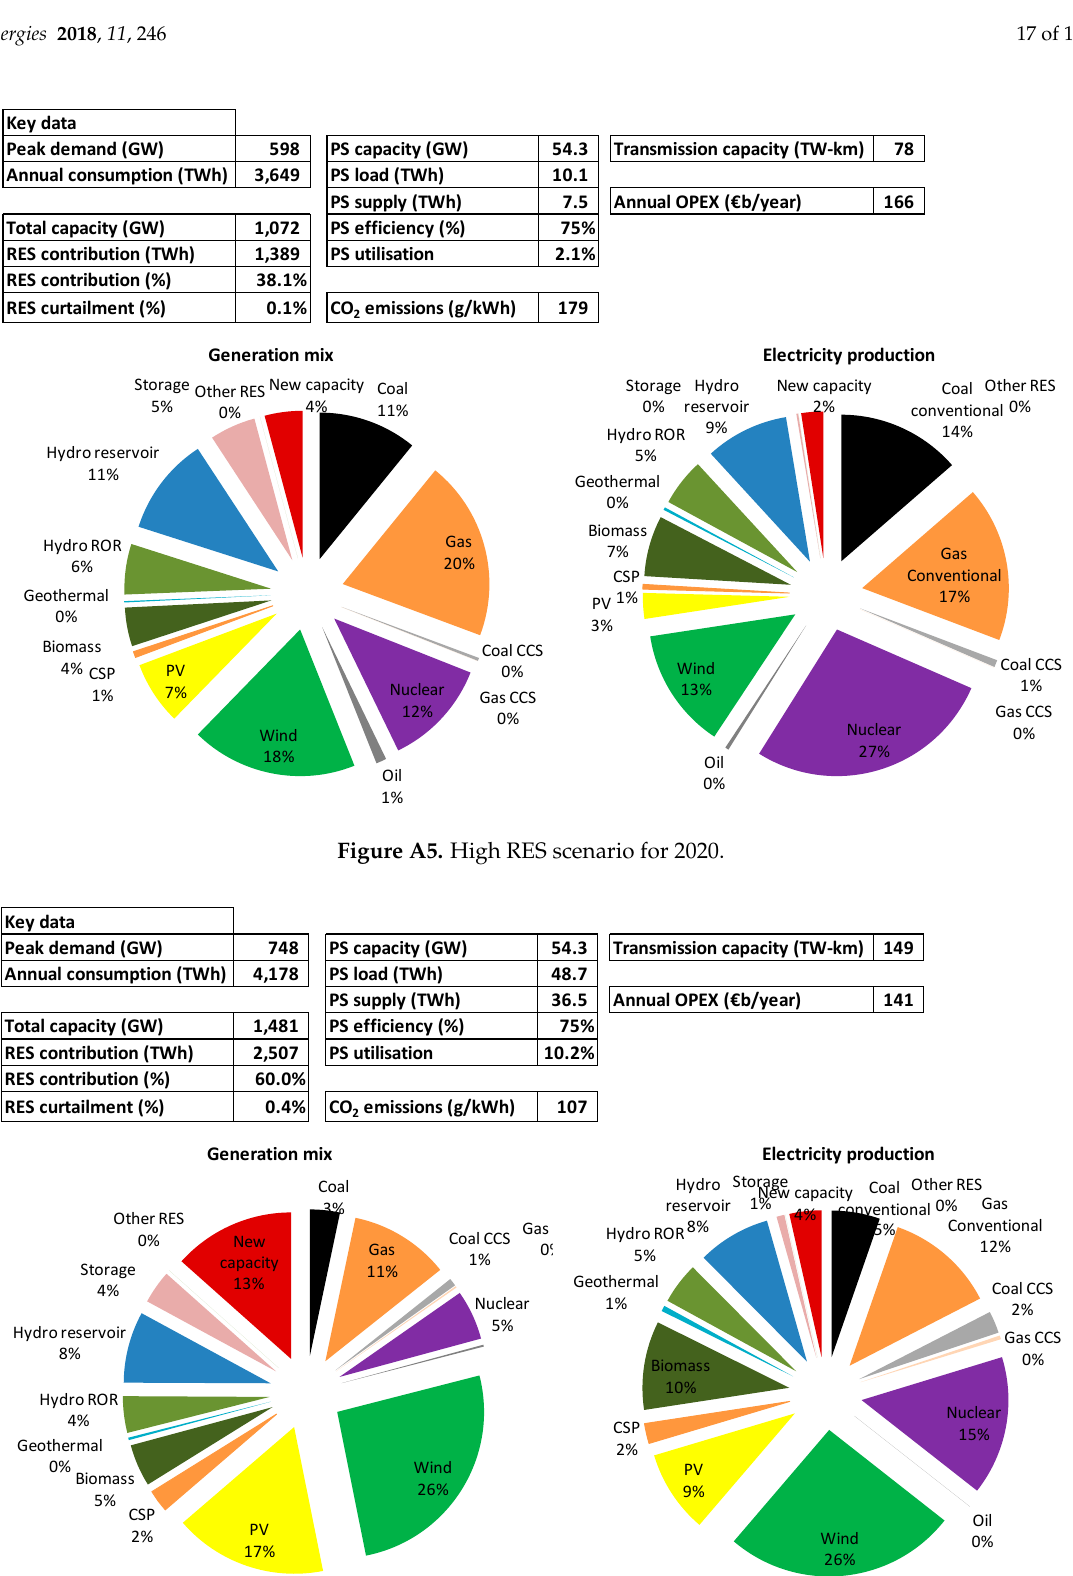
Figure A6. High RES scenario for 2030.